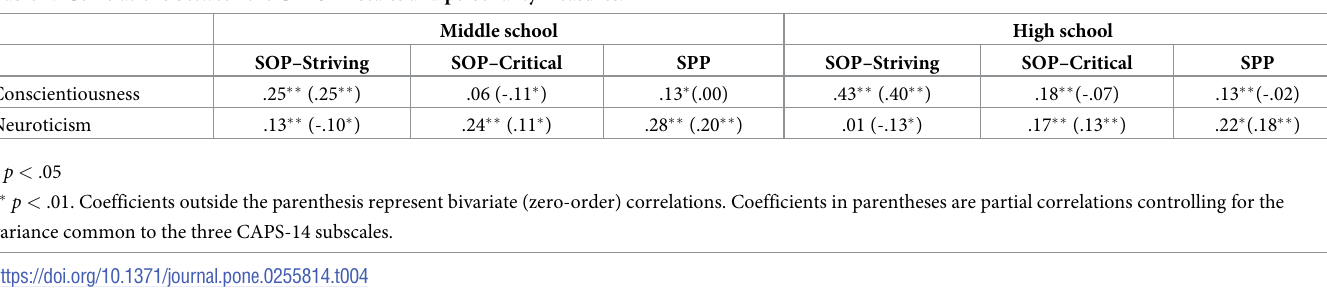
(Model 3) led to non-negligible changes in the MNCI (-.076). This suggests that the equiva- lence of intercepts is not completely tenable. Inspection of modification indices revealed that 5 equality constraints contributed most to the lack of invariance. We therefore compared Model 2 with a model that had the additional constraint of 6 intercepts, whereas the remaining 5 were free to vary (Model 4). The differences between the two models in the MCNI (-.009), the RMSEA (.001), and the SRMR (-.001) met the recommended criteria. The assumption of par- tial scalar invariance can be therefore retained. The variances and covariances of the latent fac- tors also appeared to be equivalent, as the decrement in fit that was observed after these parameters were constrained to equality turned out to be not insubstantial.